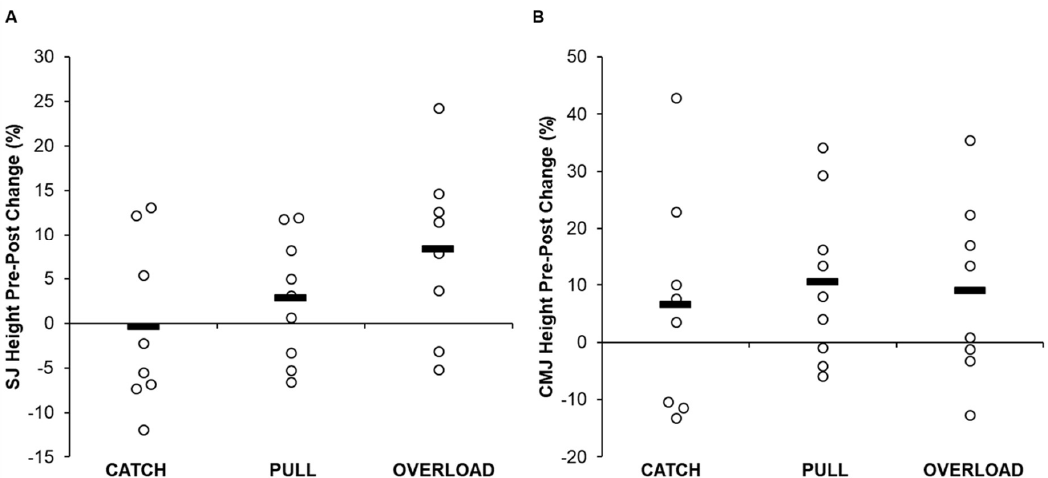
Figure 2. Pre- and post-intervention individual changes in squat jump ( A ) and countermovement jump ( B ) height. Bold line denotes group average and open circles denote individual changes.